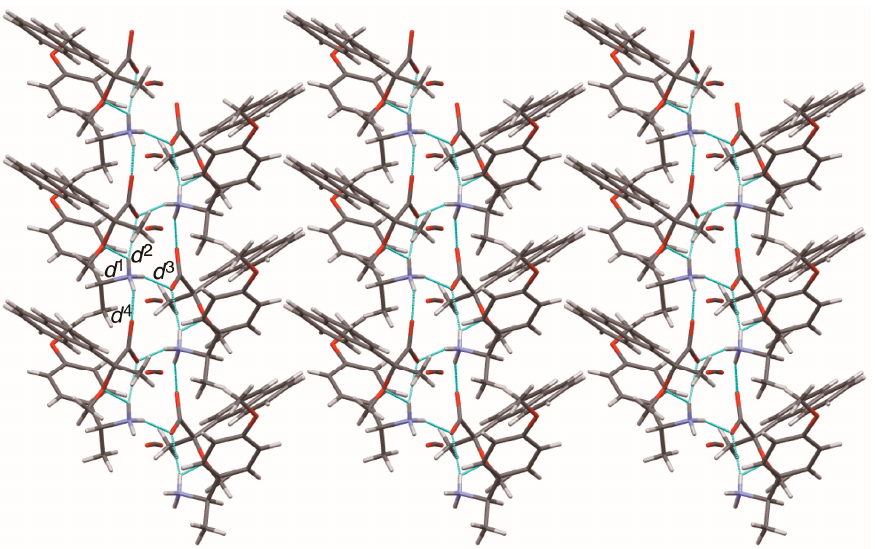
Figure 8. Sheet structure in crystalline salt 6 , consisting of 2 1 columns. The pale-blue lines show salt bridges and hydrogen bonds. See Table 3 for the interatomic distances d 1 – d 4 .